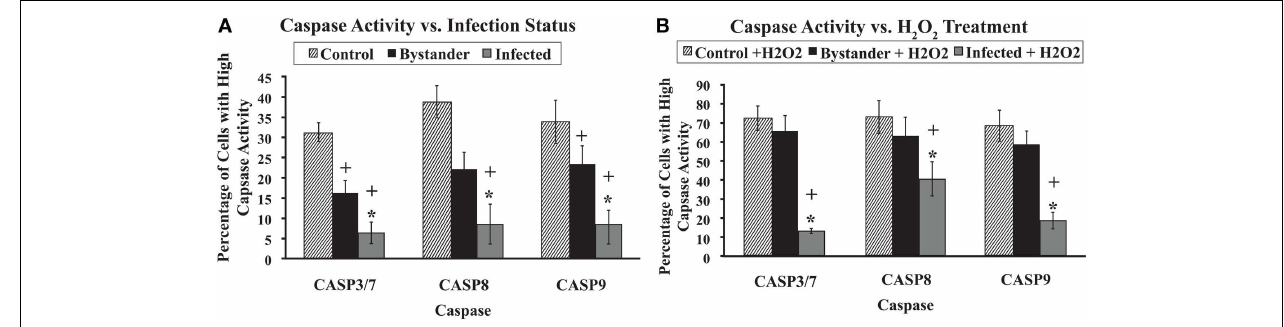
+ indicates significantly different from control, uninfected cell cultures at p < 0.05 and *indicates significantly different from bystander macrophage populations at p < 0.05. Data in (A) represents the percentage of cells with high caspase activity without any apoptosis induction. (B) Shows the percentage of cells that display high caspase activity after 20min of exposure to 100 µ m H 2 O 2